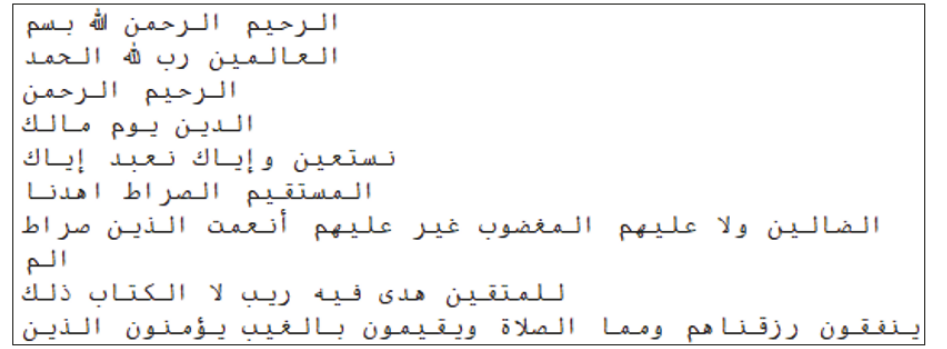
Figure 2: A part of Quranic testing set.